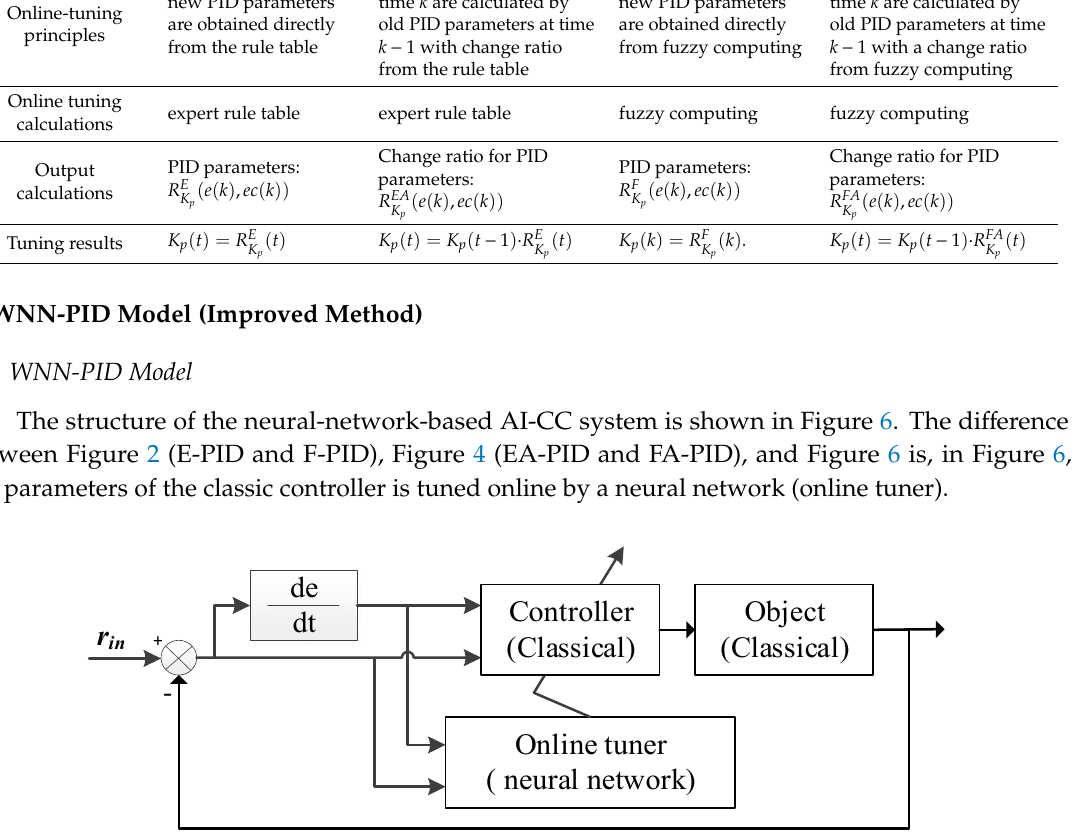
Figure 6. Structure of neural-network-based intelligent control system.